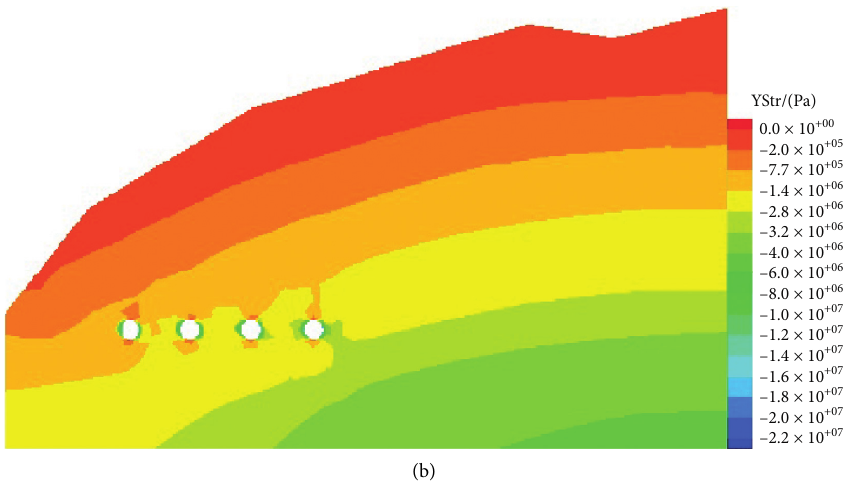
Figure 9: X - and Y -direction stress calculation with lining. (a) X -direction stress. (b) Y -direction stress.